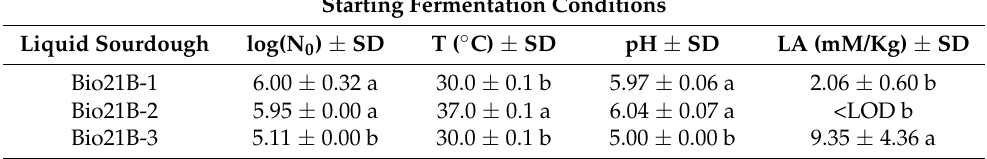
Table 1. Starting fermentation conditions used to study the metabolite evolution and growth of L. plantarum ITM21B in liquid sourdough (Bio21B) at different inoculum load log(N 0 ), temperature (T ( ◦ C), pH and lactic acid (LA)